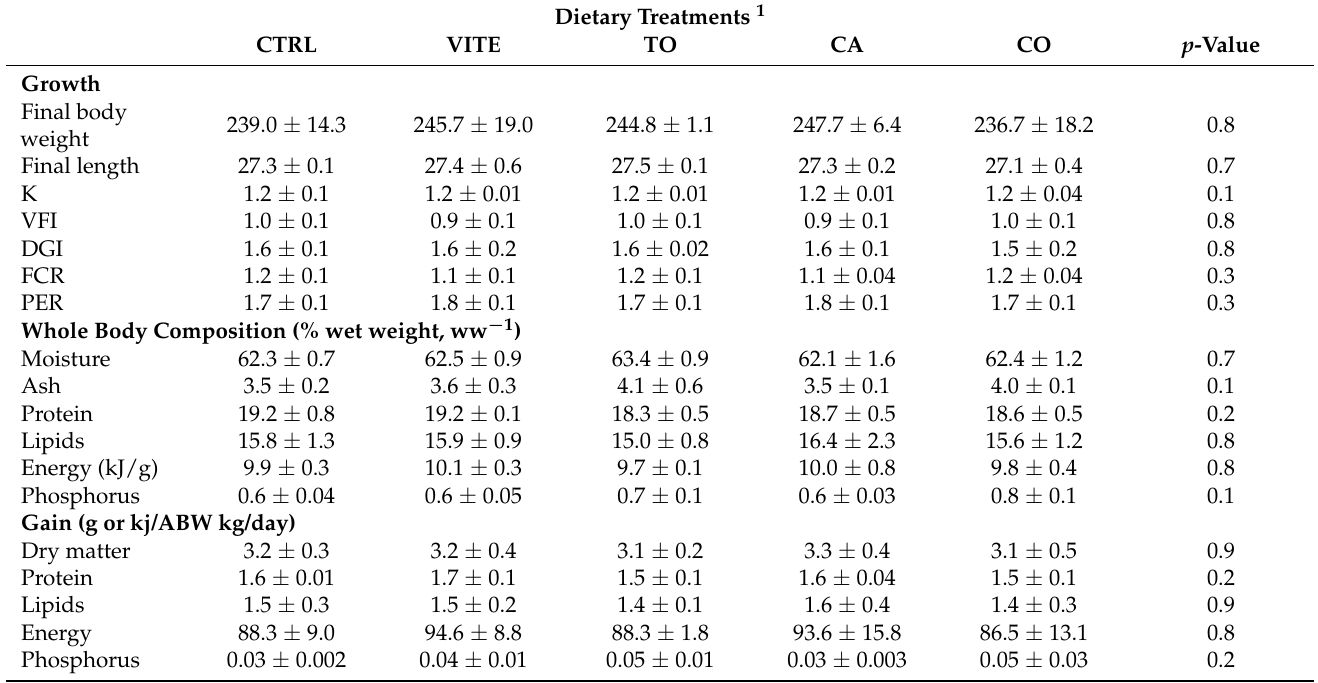
Table 3. Growth and whole-body composition of Dicentrarchus labrax fed with the experimental diets for 87